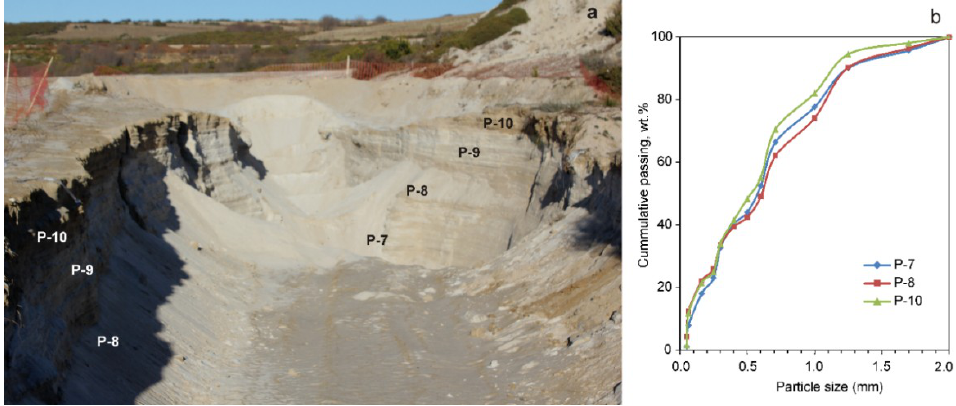
Figure 3. ( a ) Trench from Balsa Grande showing the distribution of samples 7–10. ( b ) Particle size distribution of samples. distribution of